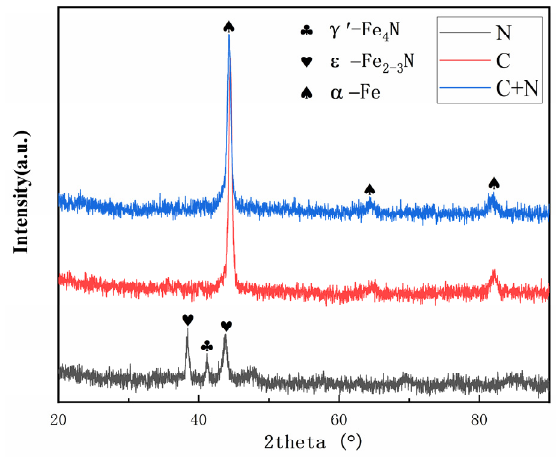
Figure 8. Surface XRD di ff ractograms of C, N and C + N states.